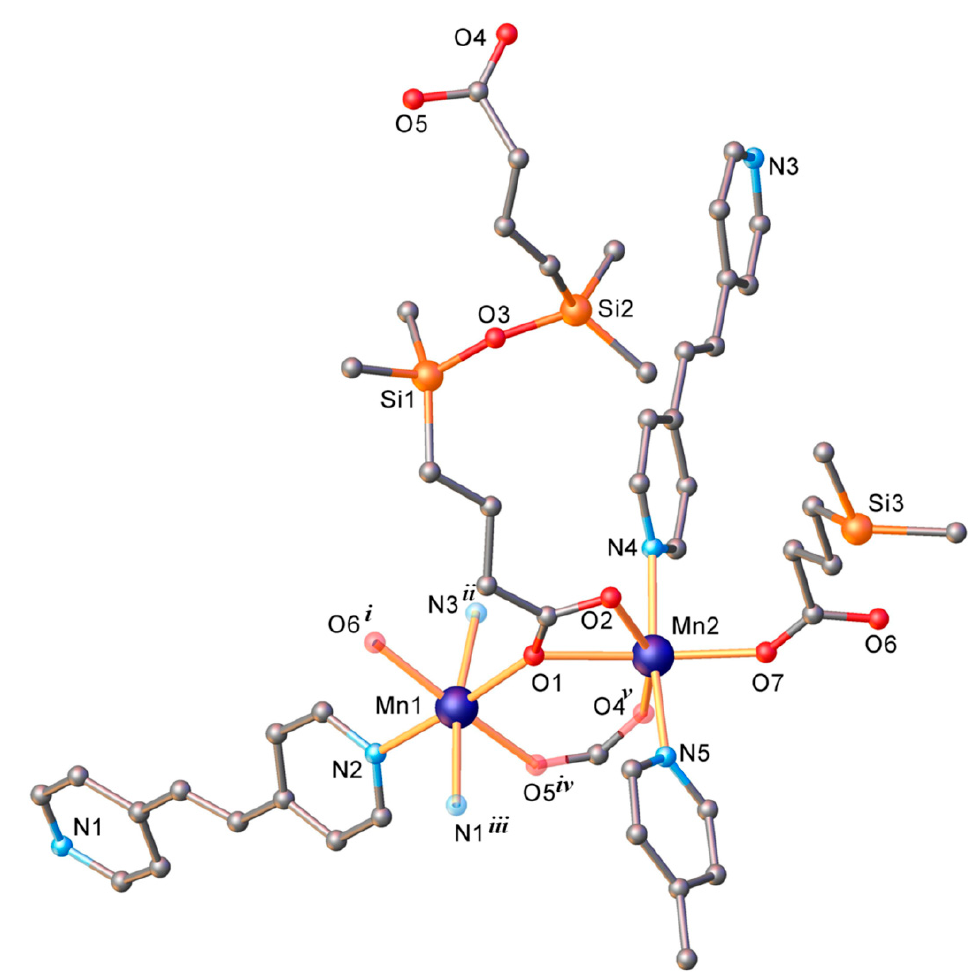
Figure 2. View of the asymmetric part showing the coordination of the Mn(II) atoms in compound 1 . The out-of-sphere ClO 4 − atoms are not shown. The symmetrical atoms are drawn with faded colors. Symmetry codes: ( i ) 1 − x , 1 − y , − z ; ( ii ) x , 1 / 2 − y , 1 / 2 − z ; ( iii ) − x , − 1 / 2 + y , 1 / 2 − z ; ( iv ) − 1 + x , 1 / 2 − y , − 1 / 2 + z ; ( v ) − 1 + x , 1 / 2 − y , − 1 / 2 + z.